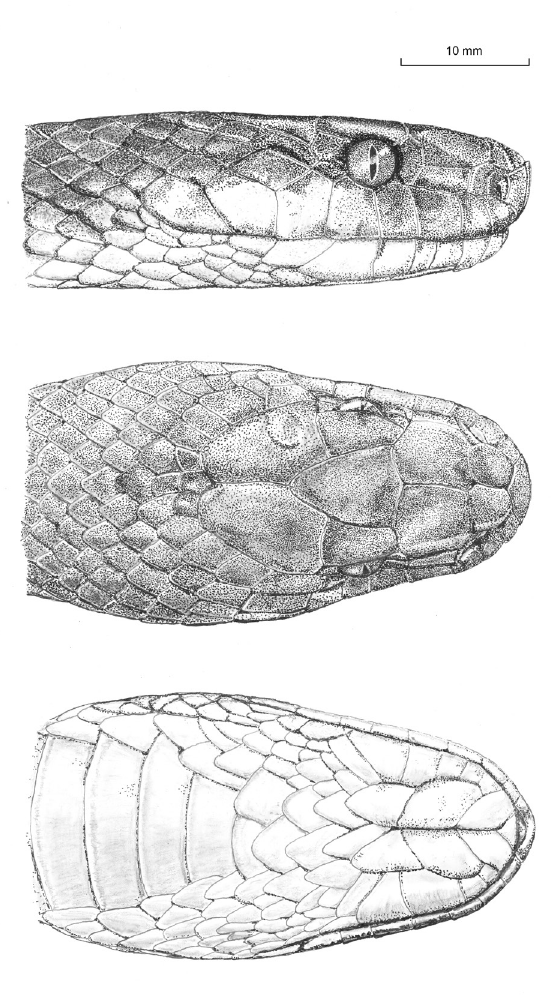
Figure 2. Head views of Oxyrhopus emberti (MNKR 2551, holotype). Illustration by Arthur